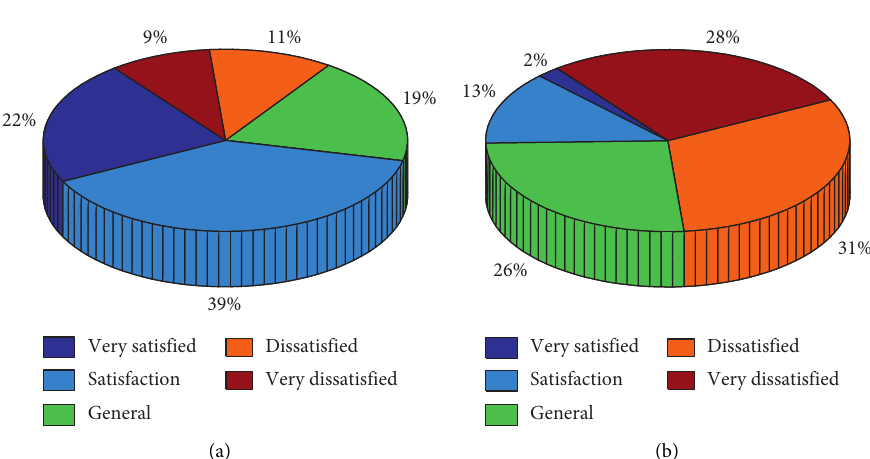
Figure 10: Learners’ satisfaction with learning resources. (a) Experimental class. (b) Control class.